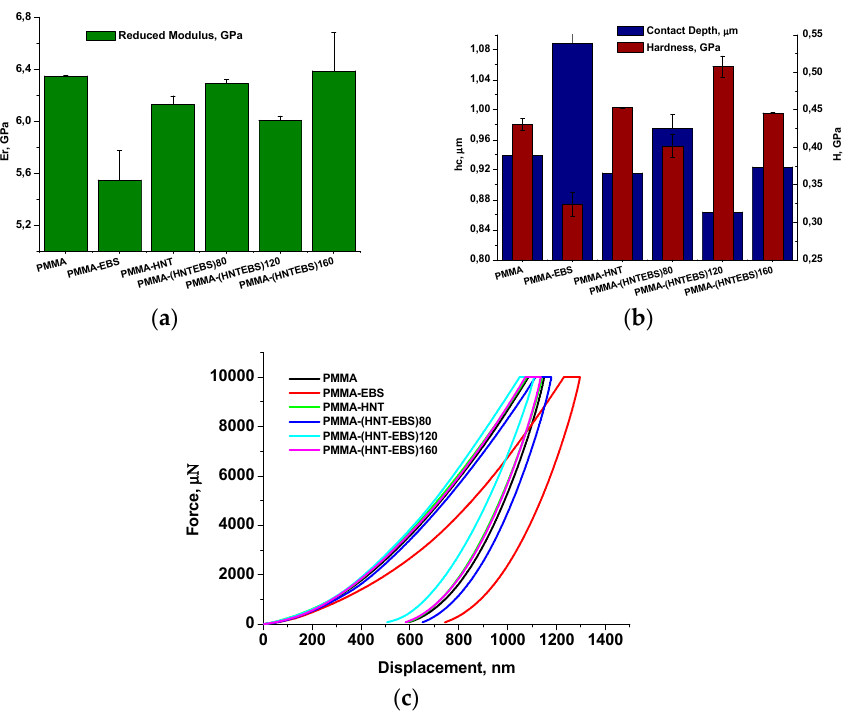
Figure 16. Comparison of ( a ) reduced modulus; ( b ) contact depth and hardness; ( c ) load–displacement plots of PMMA and PMMA/HNT nanocomposites.